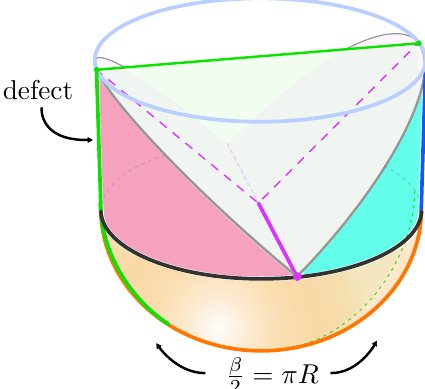
Figure 5. The Euclidean path integral (orange region) prepares the Hawking-Hartle state. The black hole temperature T = 1 / (2 πR ) is derived in section